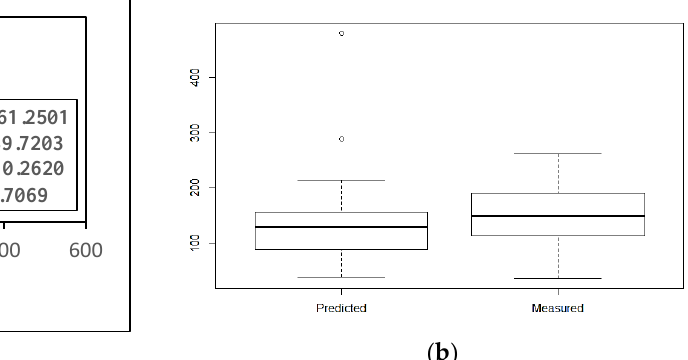
Yield measured (kg/tree) Table 4. Prediction performance of the fitted models in the testing stage. Figure 5. ( a ) Measured and predicted apple yield in testing stage of MLR; ( b ) boxplot of the measured and predicted apple yield in the testing stage of MLR. Blue dots denote the observations.